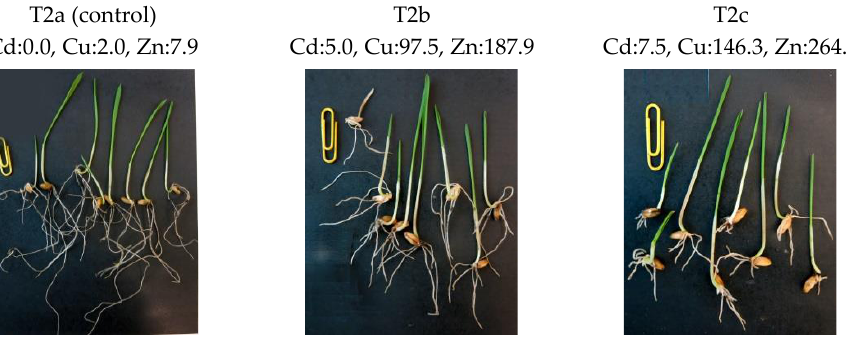
Figure 1. Germination and growth of Triticale in one of the replications in the control and treated soil on the fifth day in Trial 2. on the fifth day in Trial